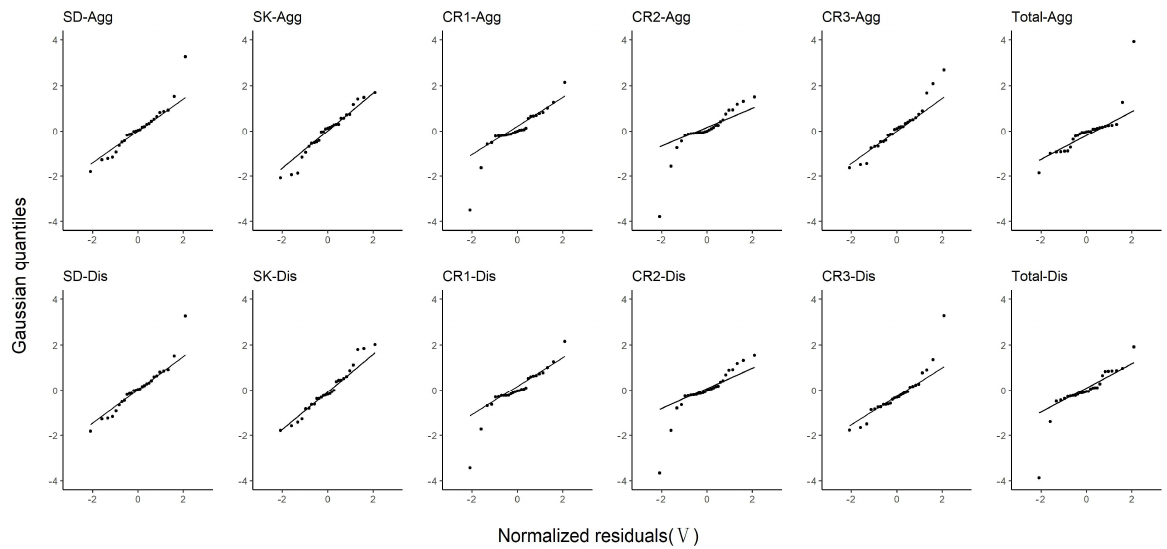
Figure 7. Gaussian probability plots of normalized residuals from the additive model and the disaggregated model for site class V.